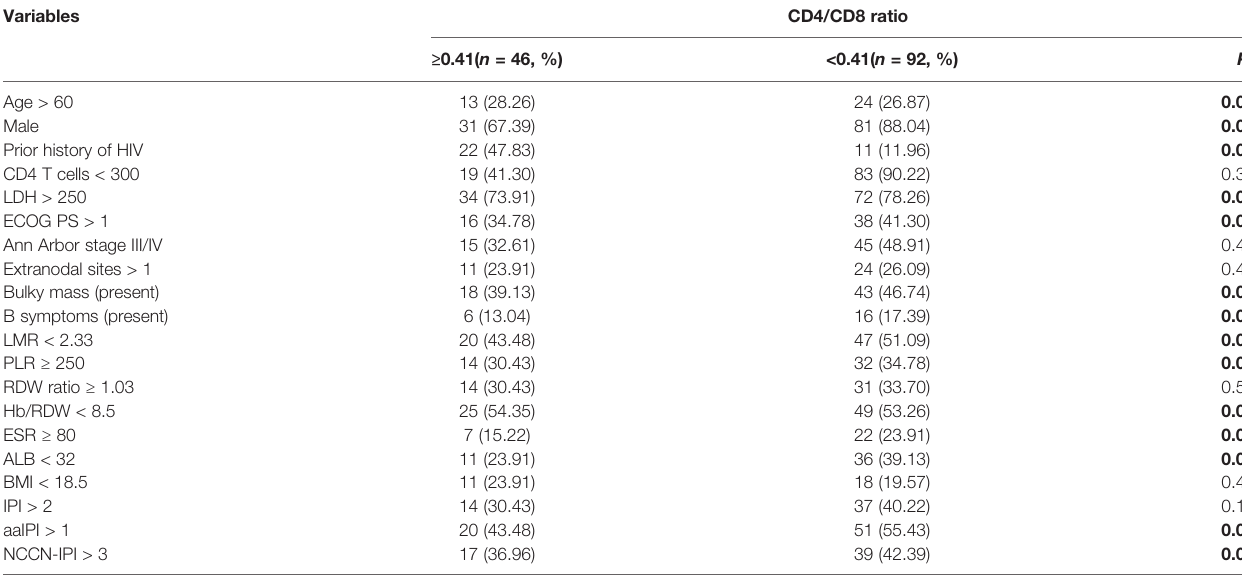
TABLE 4 | Patients ’ demographics and characteristics by CD4/CD8 ratio strati fi cation at diagnosis of AIDS-related lymphoma ( n = 138). Variables